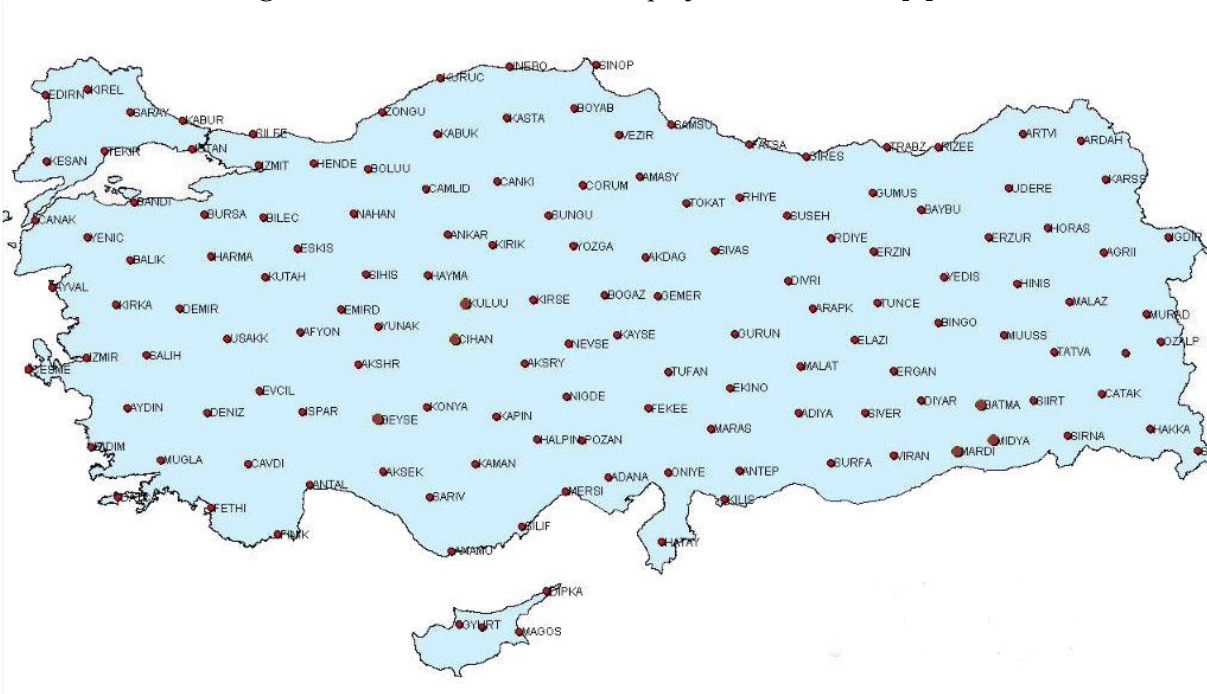
Figure 3. Locations of CORS-TR project GPS stations